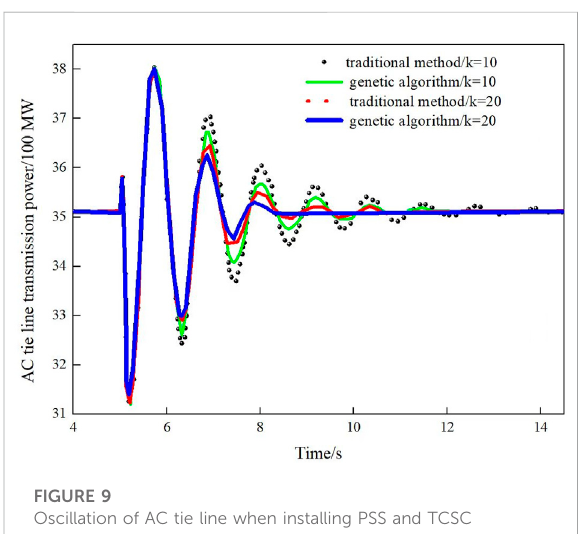
FIGURE 9 Oscillation of AC tie line when installing PSS and TCSC designed with different control